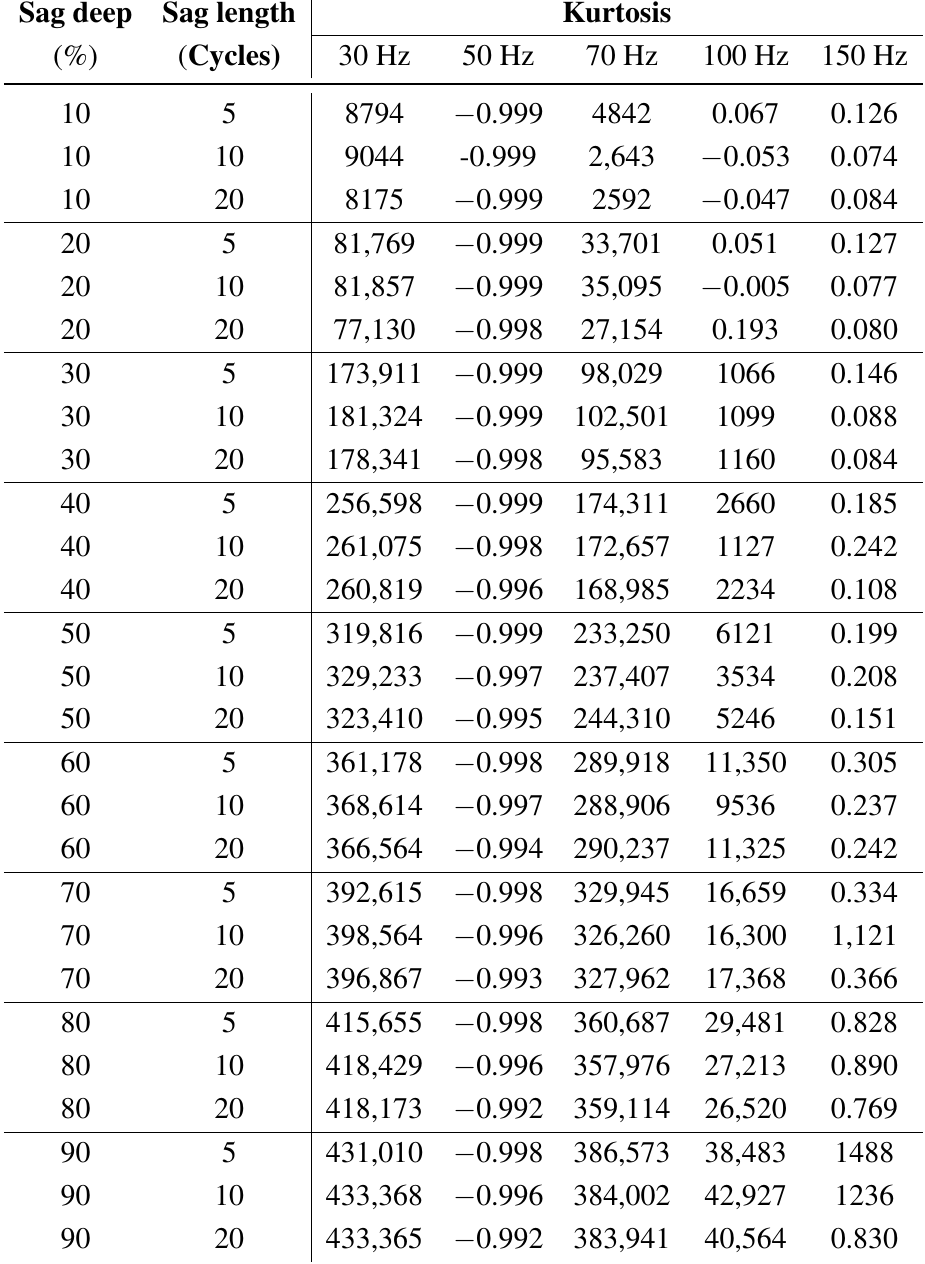
Table 2. SK analysis results for sag disturbance with different depths and